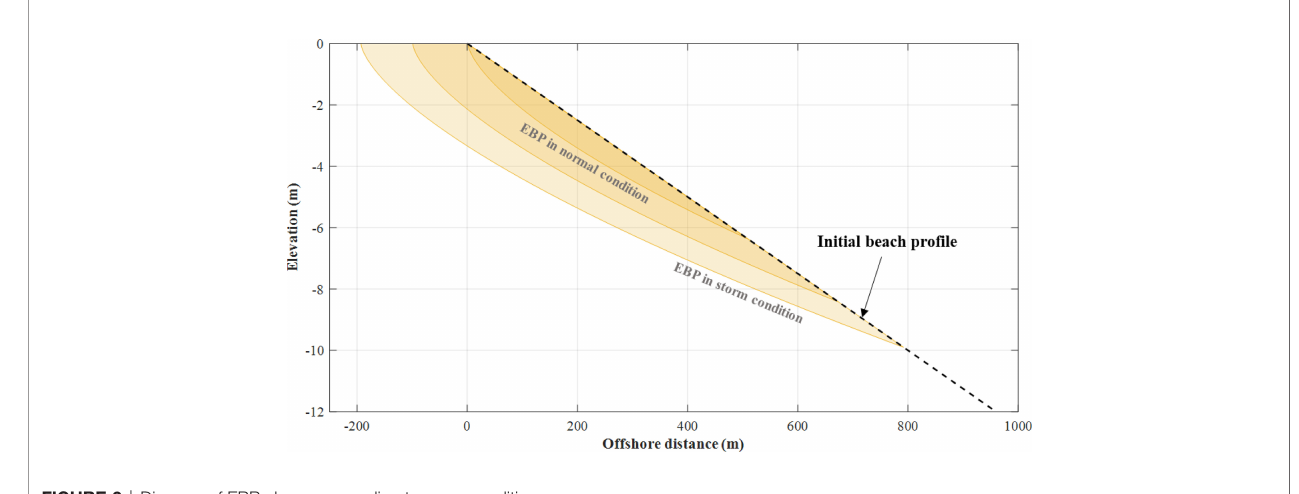
FIGURE 2 | Diagram of EBP change according to wave condition.